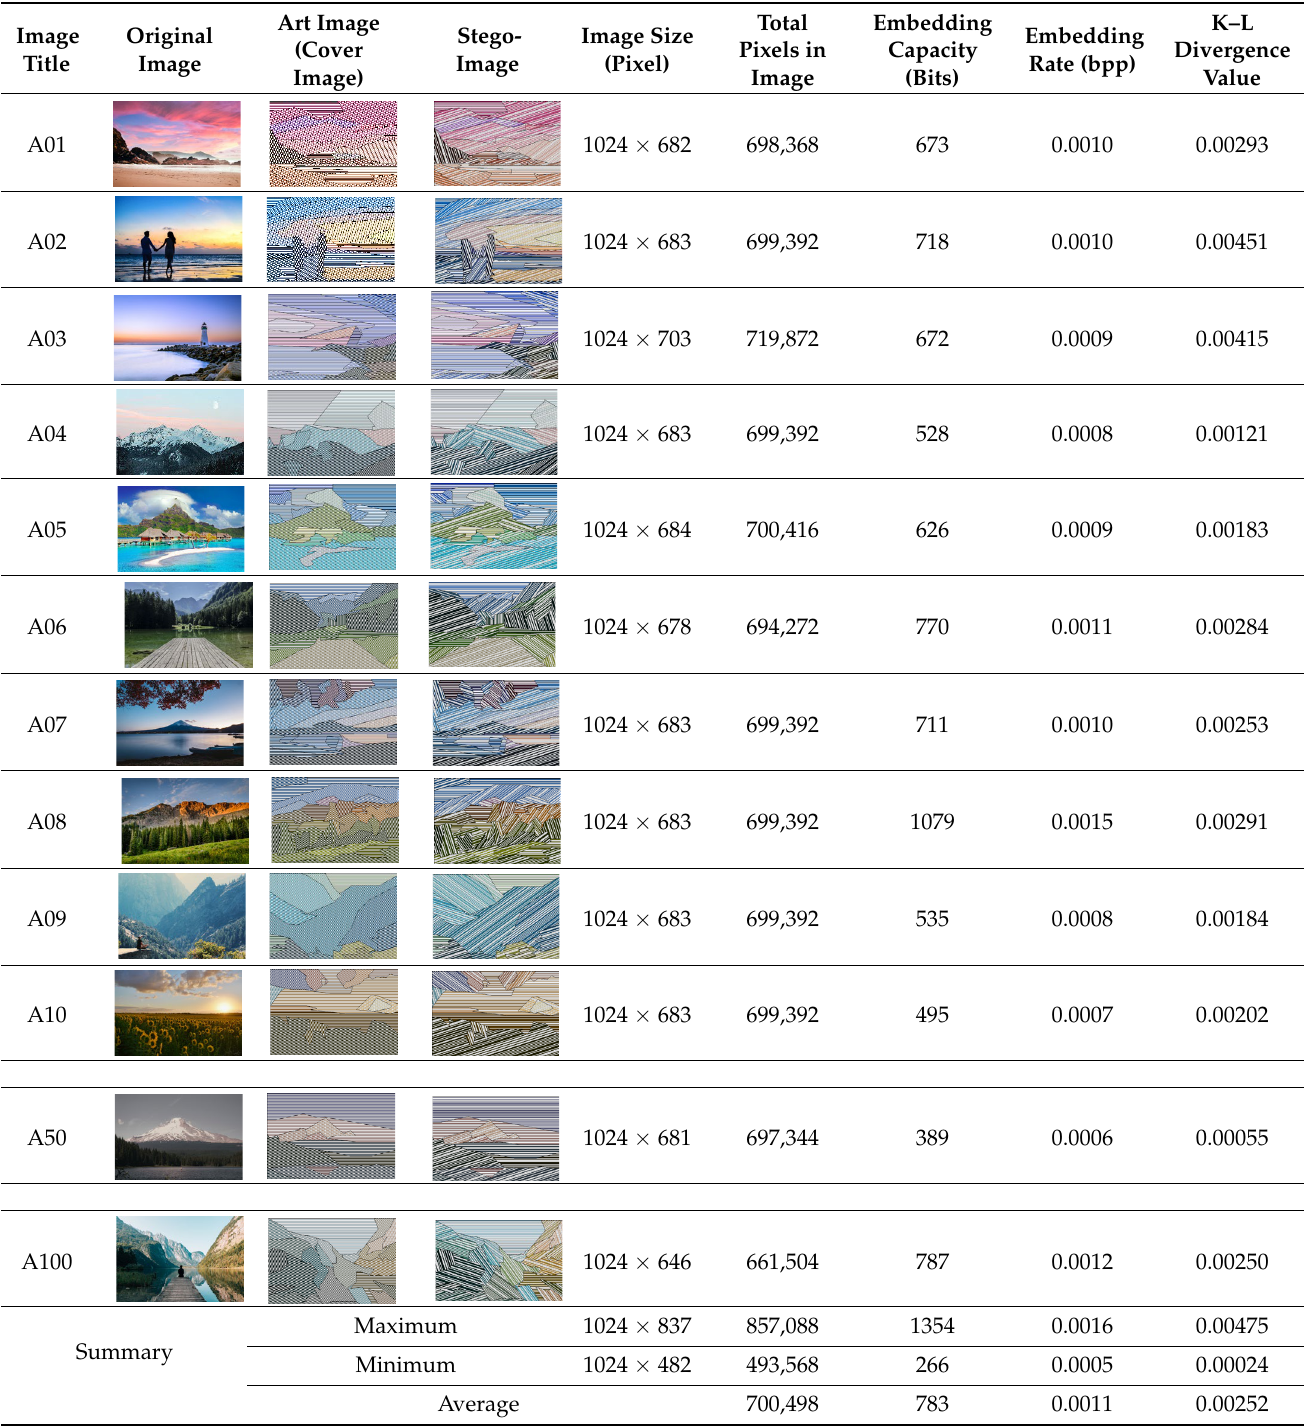
Table 4. Some statistics of 100 tested images where created art images have stripes with 6-pixel